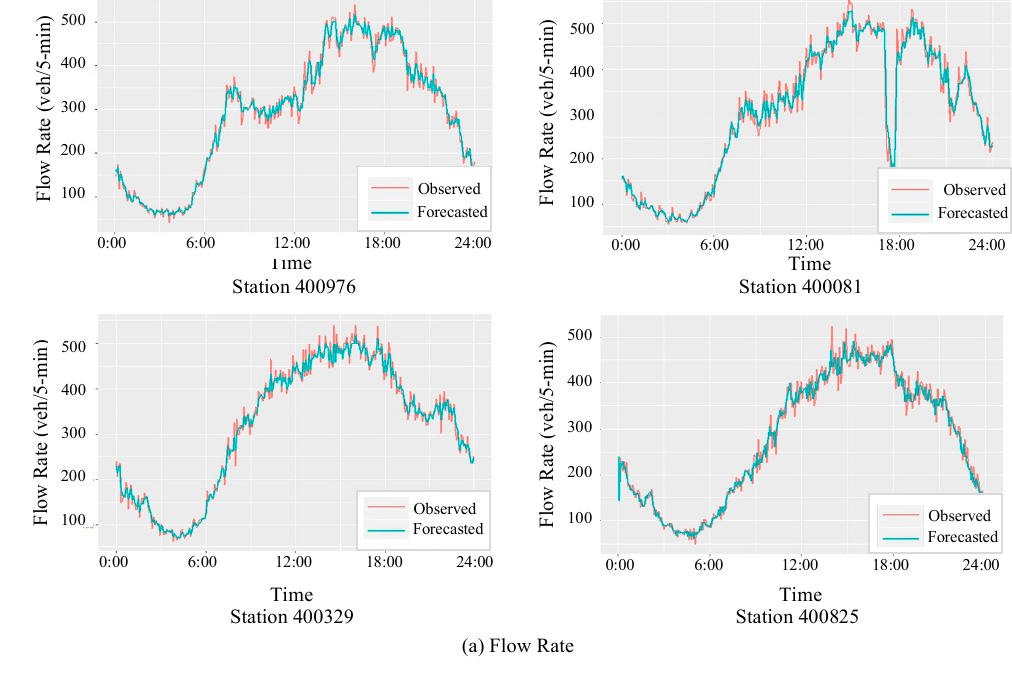
Figure 6. Performance of the comparative forecasting models associated with different stations.